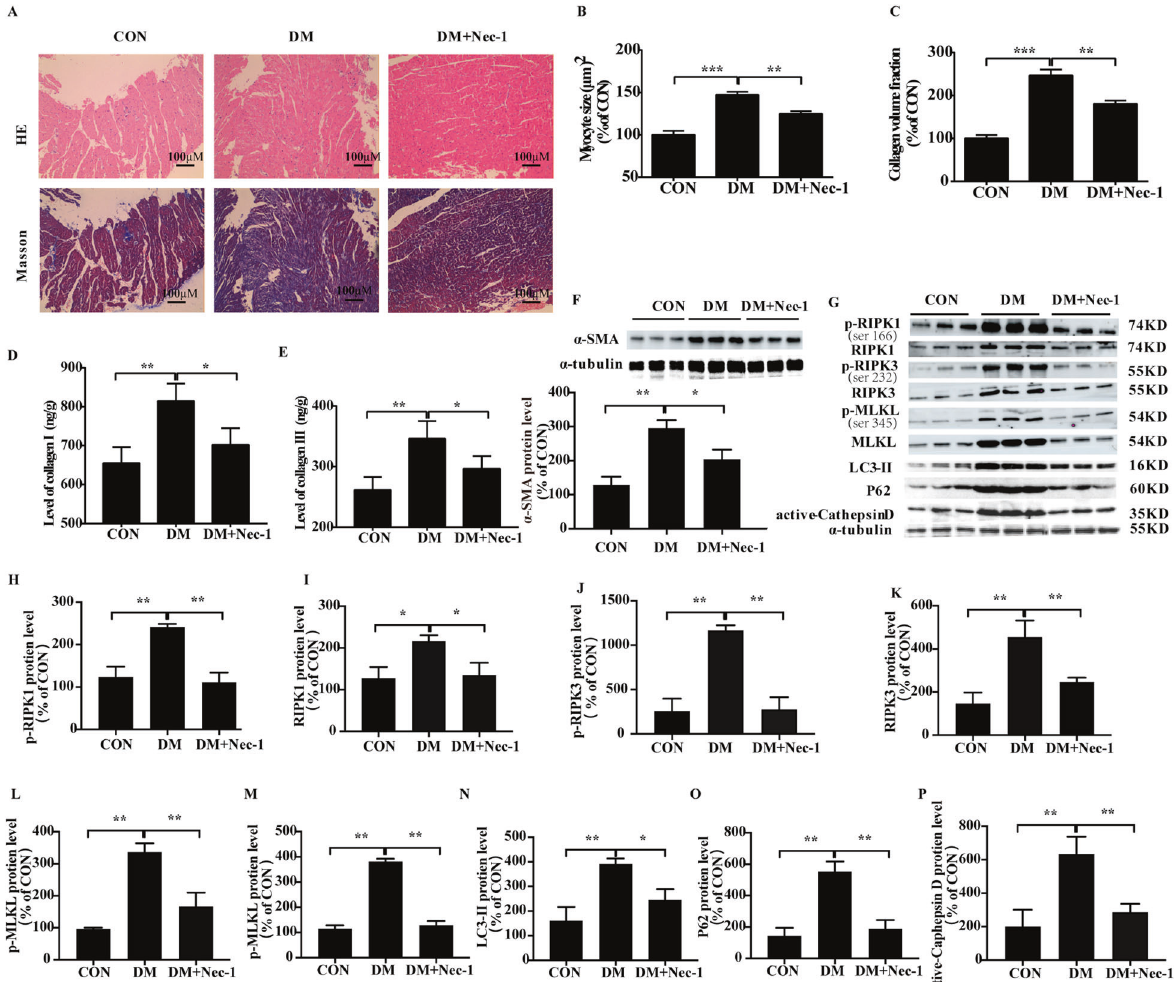
Fig. 6 Nec-1 alleviates cardiac dysfunction in diabetic rats. Myocyte size and collagen volume fraction ( A – C ). The levels of collagen I and collagen III ( D , E ). Representative images and percentages of α -SMA, RIPK1, RIPK3, MLKL, ser166-p-RIPK1, ser232-p-RIPK3, ser345-p-MLKL, LC3- II, P62 and active-cathepsin D ( F – P ); Scale bar = 100 μ m. n = 3 per group. Means ± SD. * P < 0.05, ** P < 0.01, *** P < 0.001. DM group. CON control group, DM diabetic mellitus group, HE hematoxylin-eosin staining, α -SMA α smooth muscle actin.